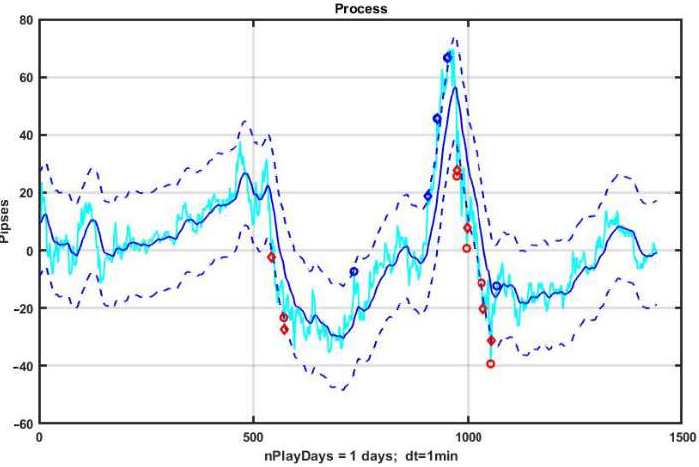
Figure 3. Example 2 of CSF implementation.